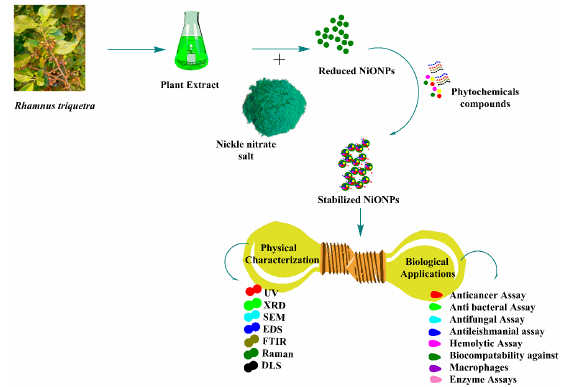
Figure 1. General overview of the study plan.